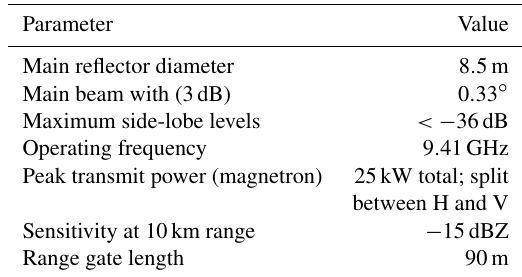
Table 1. Technical specifications of the CSU-CHILL X-band chan- nel with the dual-offset Gregorian